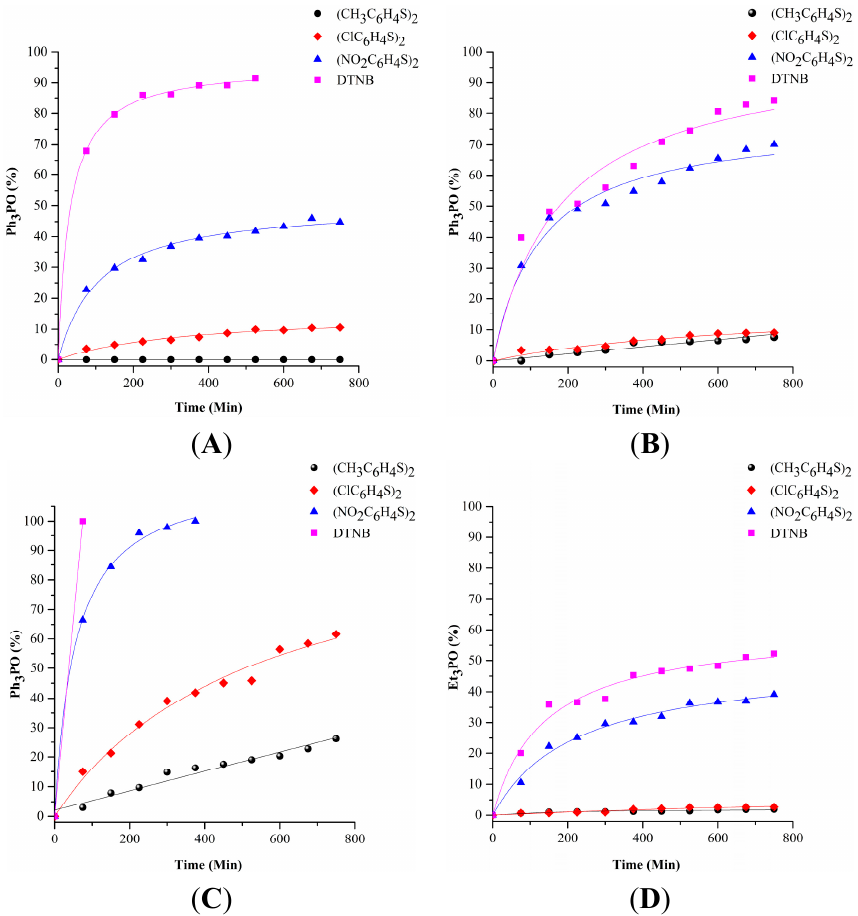
Figure 1. Formation of R 3 PO in DMSO- d 6 during reaction of 10 mM disulfides with 10 mM ( A ) Ph 3 PAu(SC 6 H 4 CH 3 ); ( B ) Ph 3 PAu(SC 6 H 4 Cl); ( C ) Ph 3 PAu(SC 6 H 4 NO 2 ); ( D ) Et 3 PAu(TATG) (auranofin). The percentage of R 3 PO was calculated as the ratio of R 3 PO to the total phosphorus in the 31 P{ 1 H}